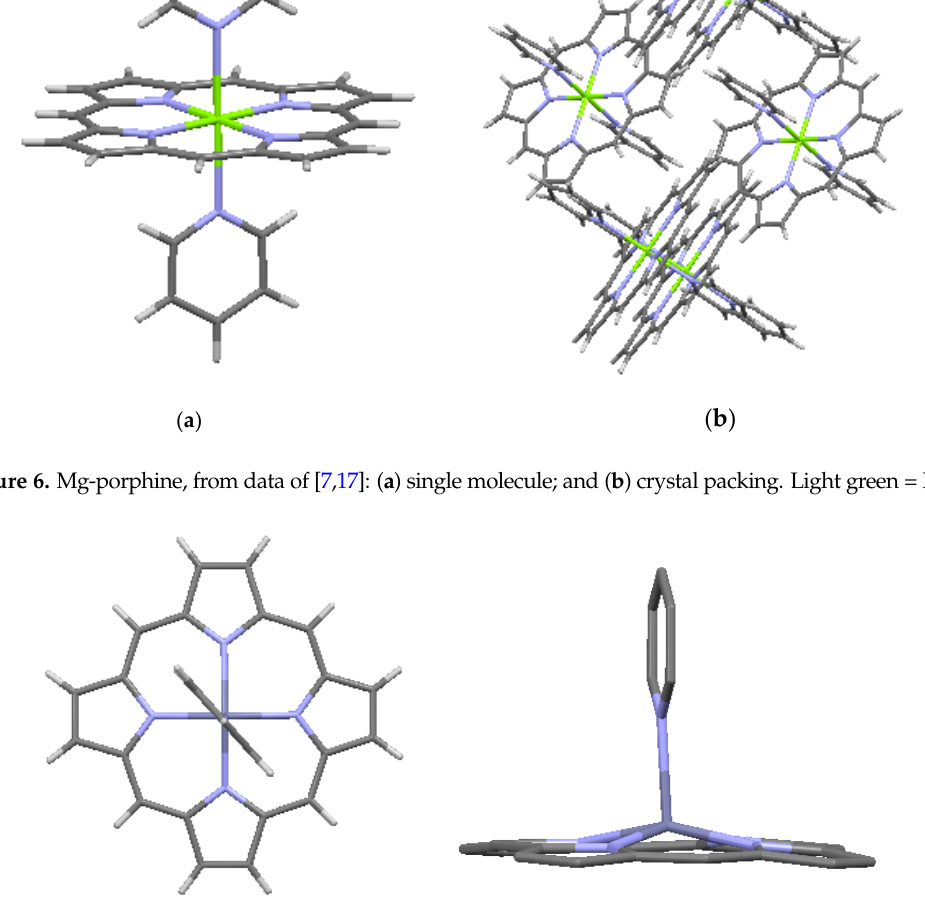
( b ) Figure 8. Ge-porphine, after data of [7,18]: ( a ) top view; and ( b ) side view. Dark green = Ge, red = O. Devillers et al. [10] have calculated average bond lengths and bond angles for the pyrrole units among a sampling of eight porphine macrocycles (including both non-metalated and metalated, but with no substituents). The results do not deviate significantly from the mean values. Thus, based on this small sample, the effect of metalation by itself on the crystallographic dimensions of the macrocycle appears to be small. However, the presence of ligands axially bonded to the metals may sterically require differences in the overall stacking mode, which can affect the overall crystal properties. As noted by Fleischer [19], the coordination of the metal in metalated porphyrins, depending on the metal, may be described as: four-coordinated (square-planar), five-coordinated (square pyramidal), six-coordinated (distorted octahedral), or eight-coordinated (square-antiprismatic, as when sandwiched in a dimer). The type of coordination is influenced by the size of the metal ion. Divalent metals that can readily fit into the plane of the macrocycle core can have square-planar coordination, as shown for the nickel in Figure 5. High-spin ferric iron has five-coordination, with a halogen at the apex, and the four nitrogens at the base of the coordination pyramid. The germanium in Figure 8 can be regarded as octahedrally coordinated. Seven-coordination is also possible when the metal is out of the macrocycle plane. The metal coordination can have a substantial effect on the optical absorption spectrum and the electrical and magnetic properties. 5. Role of Covalent Inter-Molecular Bonding